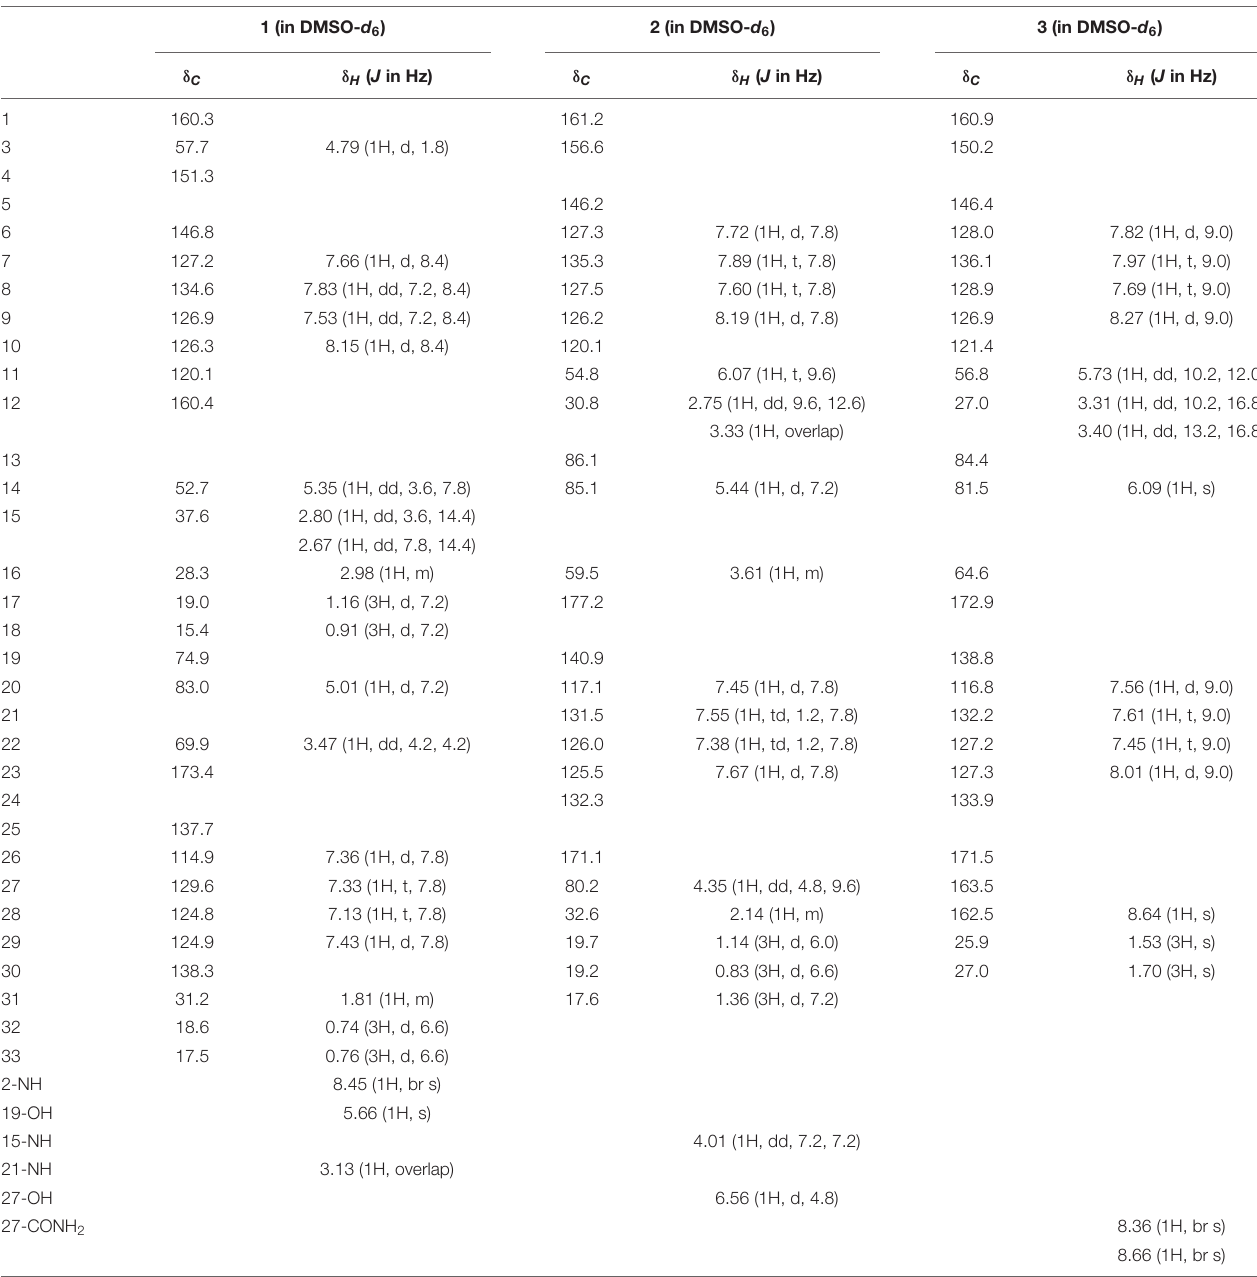
TABLE 1 | 1 H (600 MHz) and 13 C NMR (150 MHz) data of compounds 1 – 3